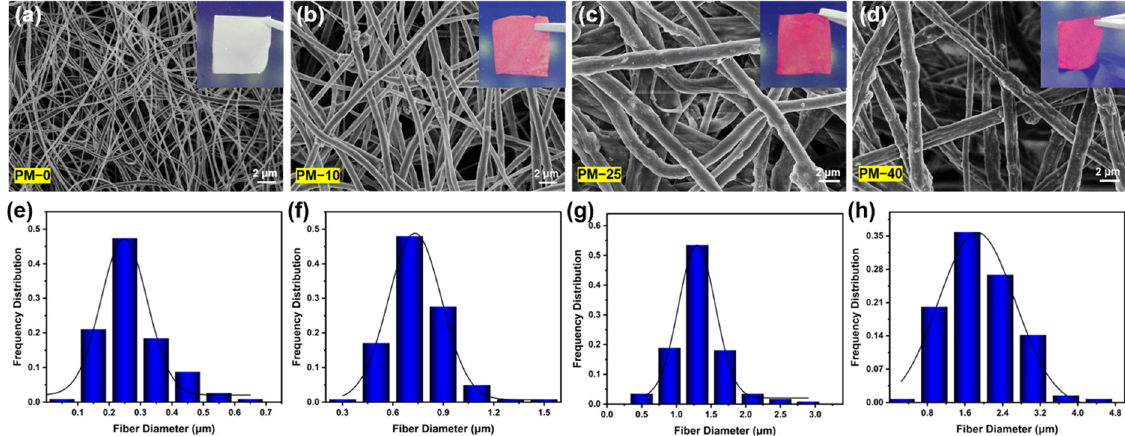
Figure 3. ( a – d ) Scanning electron microscope (SEM) images of PM − 0, PM − 10, PM − 25, and PM − 40 NFMs, the inset show the Photos of corresponding NFMs under UV lamp irradiation. ( e – h ) The corresponding diameter distributions of various membranes ( n = 100).